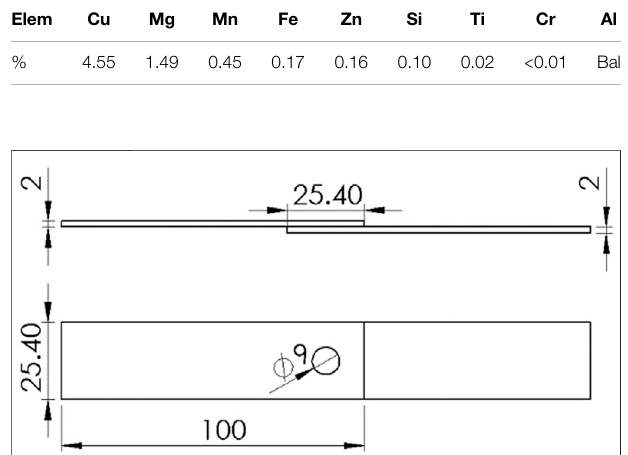
FIGURE3| Con fi gurationanddimensionsofthejointsusedforlapshear test (in